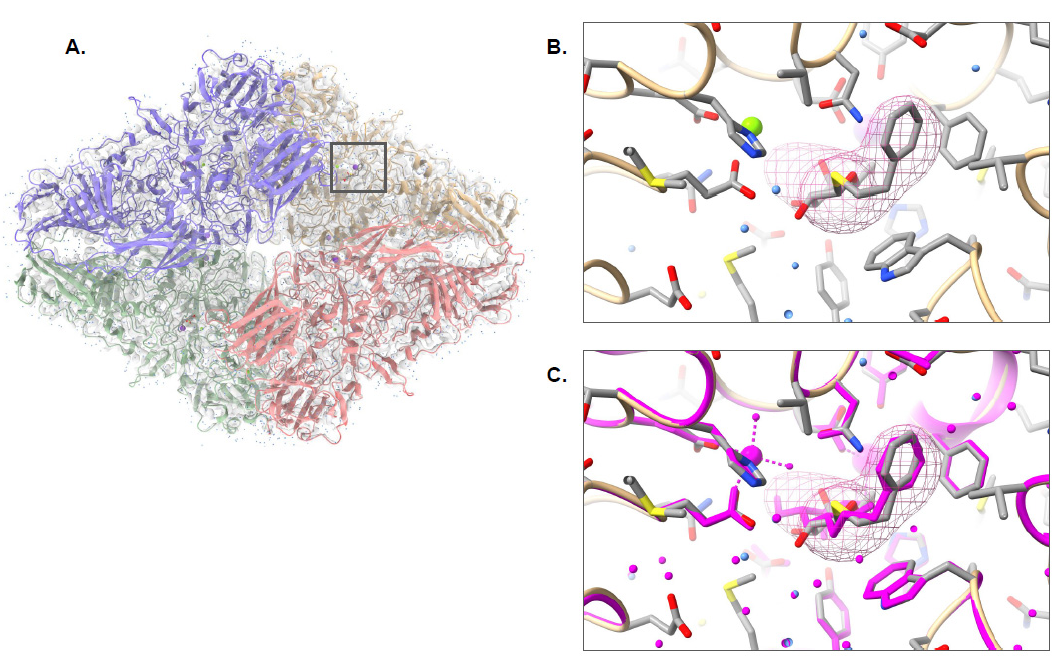
Figure 4. Pathwalking and ligand identification: EMD-7770. The complete Pathwalking model for β -galactosidase, including water (blue) and ligands (gray) is shown in ( A ). A zoomed-in view of the identified ligand location, marked by a square in ( A ), by pw_ligands.py is shown as a cage in ( B ). The fitted and refined ligand, along with the water (blue) and protein models (colored by chain) are shown as well. In ( C ), the published model (magenta) is shown superimposed on the Pathwalking